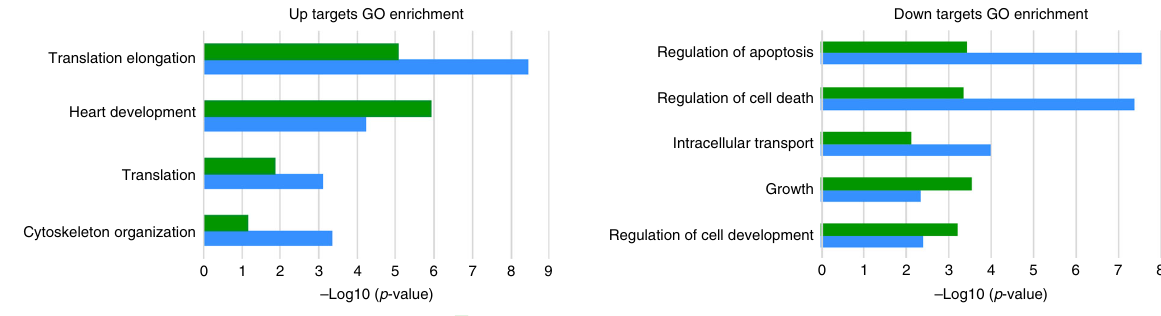
Fig. 5 BRD9 directly regulates gene expression. a Western blot of selected histone modi fi cations in G401 cells with or without BRD9. b , c Scatterplot of the average H3K27Ac ( b ) and H3K4me3 ( c ) ChIP-seq signals in H3K27Ac -WT and H3K27Ac -KD BRD9 over BRD9 binding sites. Loss of BRD9 leads to bidirectional changes of H3K27Ac and H3K4me3. d Correlation between the closest gene expression changes with H3K27ac signal changes at TSS- proximal and TSS-distal regions upon BRD9 deletion. In the box plots, bounds of the box spans from 25 to 75% percentile, the center line represents median, and whiskers visualize 5 and 95% of the data points. e BETA activating/repressive function prediction of the BRD9 class I and class II peaks in G401 cell. The red and the purple lines represent BRD9 upregulated and downregulated genes, respectively. The dashed line indicates the non-differentially expressed genes as background. Genes are cumulated by the rank on the basis of the regulatory potential score from high to low. The regulatory potential in the x -axis represents the likelihood of a gene being regulated by BRD9, calculated by considering both the number of BRD9 binding sites and the distance between gene TSS and the BRD9 peak (see details from methods). P - values that represent the signi fi cance of the upregulated or downregulated gene group distributions are compared with the static gene group by the Kolmogorov – Smirnov test. f GO terms enrichment of BRD9 class I and BRD9 class II direct up (left) and down (right) target genes upon BRD9